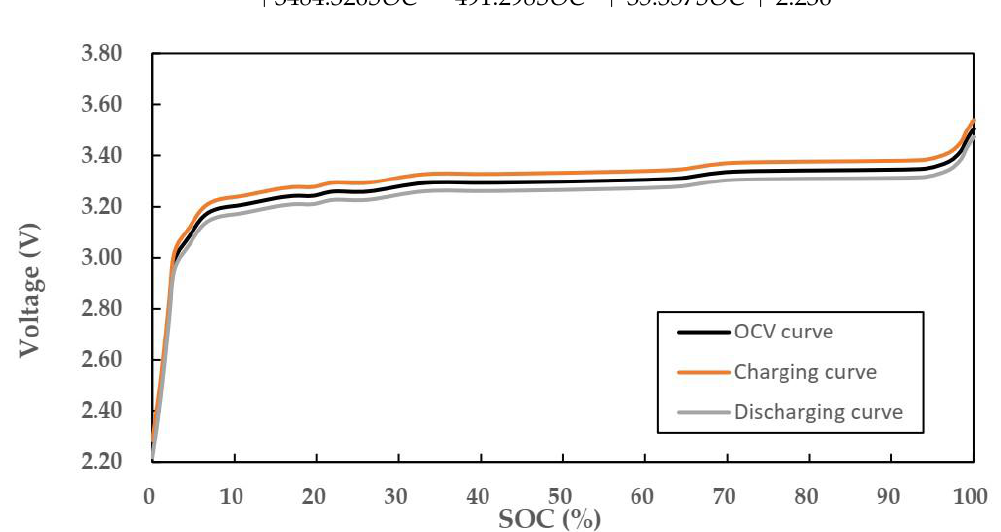
Figure 1. OCV-SOC Figure 1. OCV-SOC curve.